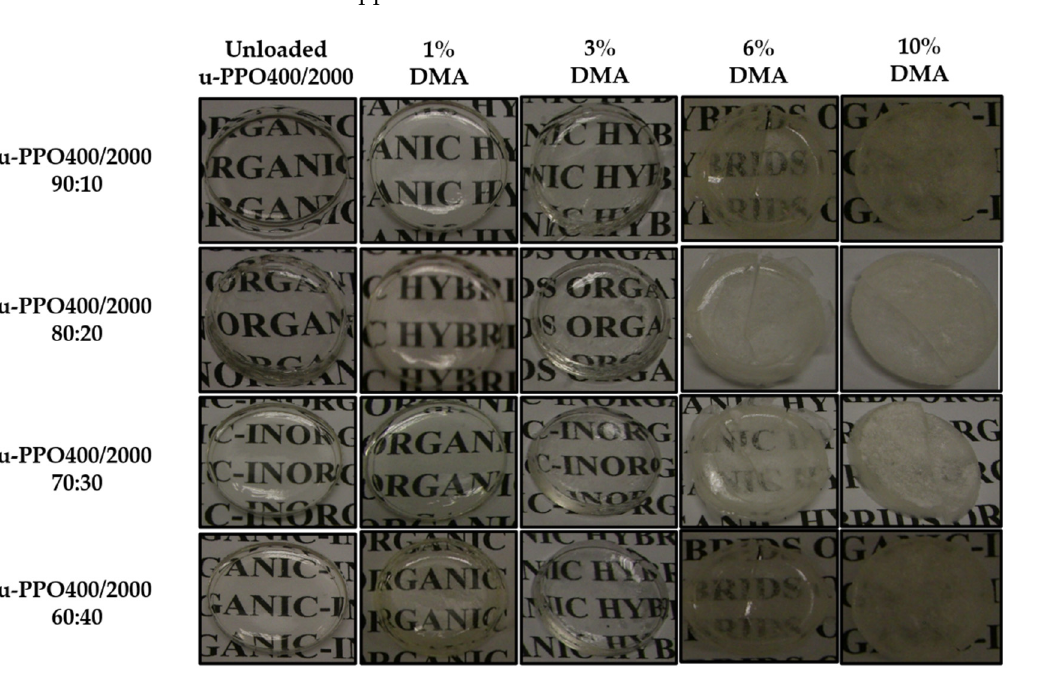
Figure 2. Visual characteristics of membranes from mixtures of the ureasil–polyether precursor: u-PPO400/2000 in the proportions of 90:10; 80:20; 70:30 and 60:40 without dexamethasone and containing 1, 3, 6 and 10% dexamethasone. Abbreviation: DMA = dexamethasone.